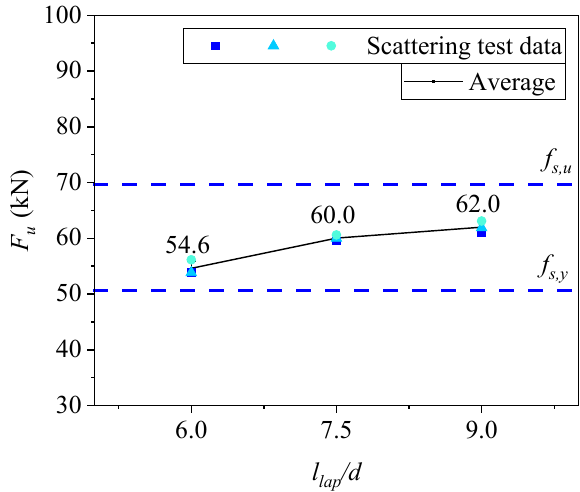
Figure 13. Relationship between lap length and bearing capacity.